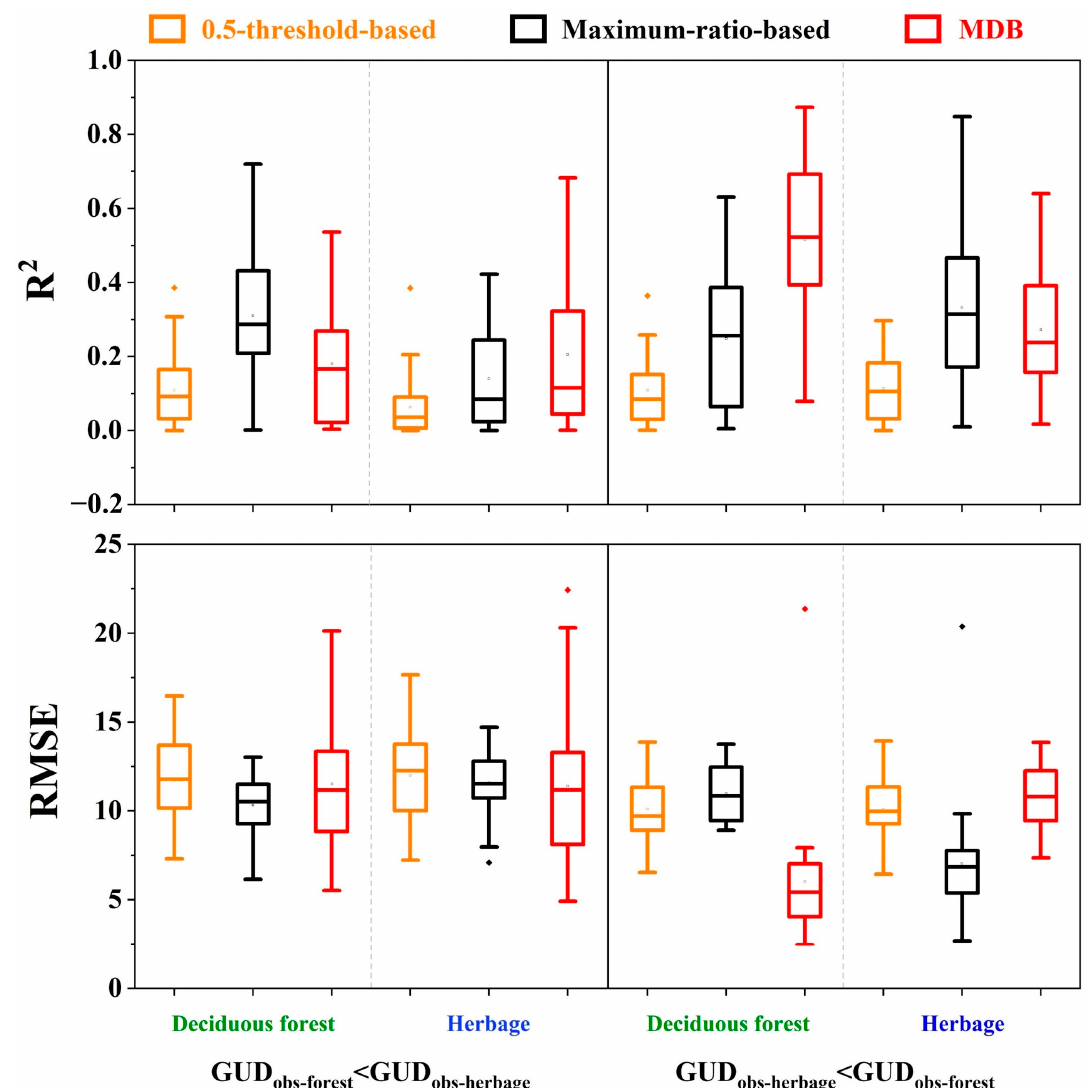
Figure 8. Comparisons of three predicted methods (0.5-threshold-based method, Maximum-ratio-based method, and Maximum-derivative-based (MDB) method) for reproducing temporal variations of green-up date (GUD) by using coefficient of determination ( R 2 ) and the root mean square error (RMSE) between estimated GUD and observed GUDs of deciduous forest and herbage across all forest-herbage-mixed (FHM) sites with GUD obs-forest < GUD obs-herbage and with GUD obs-herbage < GUD obs-forest .